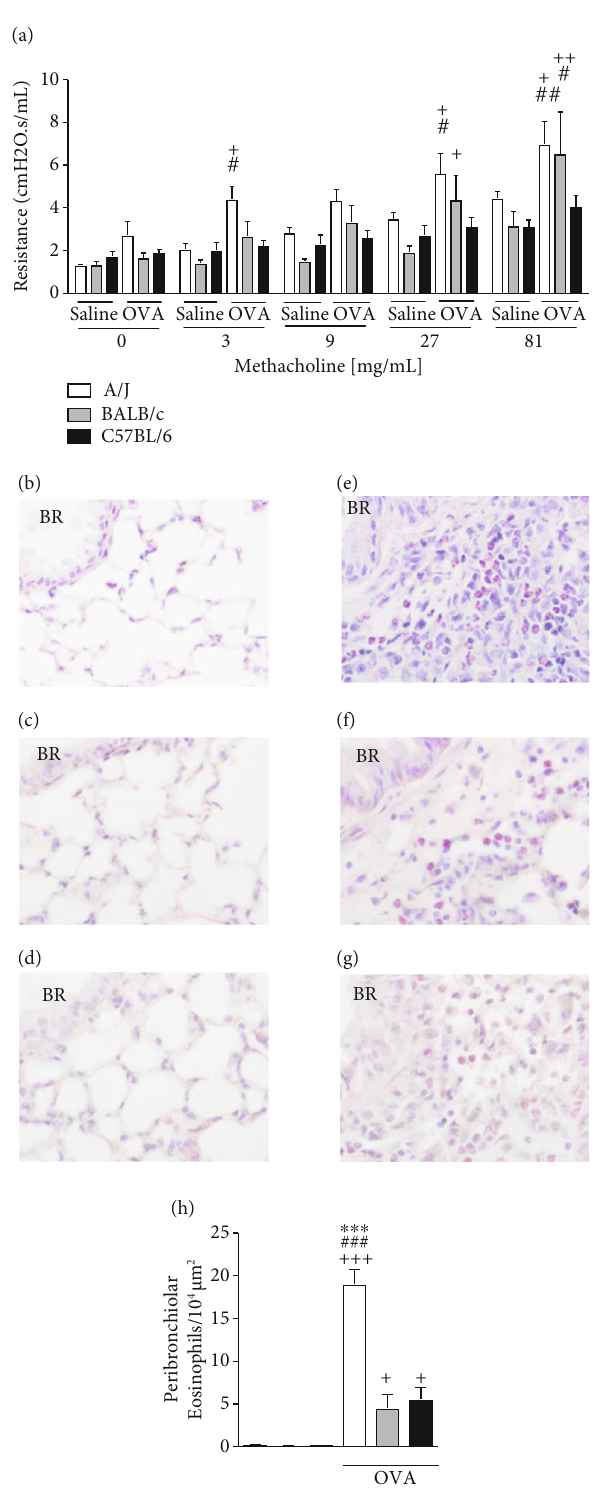
Figure 1: Assessment of airway resistance and eosinophilic in fl ammation in saline or OVA-challenged A/J, BALB/c, or C57BL/6 mice. Lung resistance was induced by increasing concentrations of methacholine bronchoprovocation, evaluated 24h after the last OVA challenge (a). Photomicrographs of representative airways stained by Sirius Red of saline-challenged A/J (b), BALB/c (c), or C57BL/6 (d) and OVA- challenged A/J (e), BALB/c (f), or C57BL/6 (g) mice (original magni fi cation 1000x). Quantitative data for eosinophils is shown in (h). Values represent the mean ± SEM of 4-6 animals per group. + P < 0 : 05 , ++ P < 0 : 01 , and +++ P < 0 : 001 as compared to the respective saline- challenged mouse strain group. # P < 0 : 05 , ## P < 0 : 01 , and ### P < 0 : 001 as compared to OVA-challenged C57BL/6 mice. ∗∗∗ P < 0 : 001 as compared to OVA-challenged BALB/c